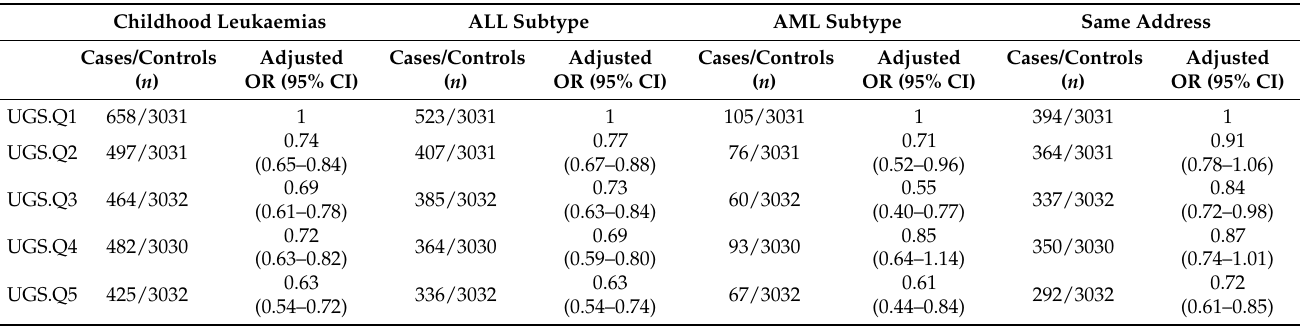
Table 2. Results of the UGS analysis for overall childhood leukaemias, ALL and AML subtypes, and identified cases with same address at birth and diagnosis. Adjusted models for sex, year of birth, SES, and activity rate.